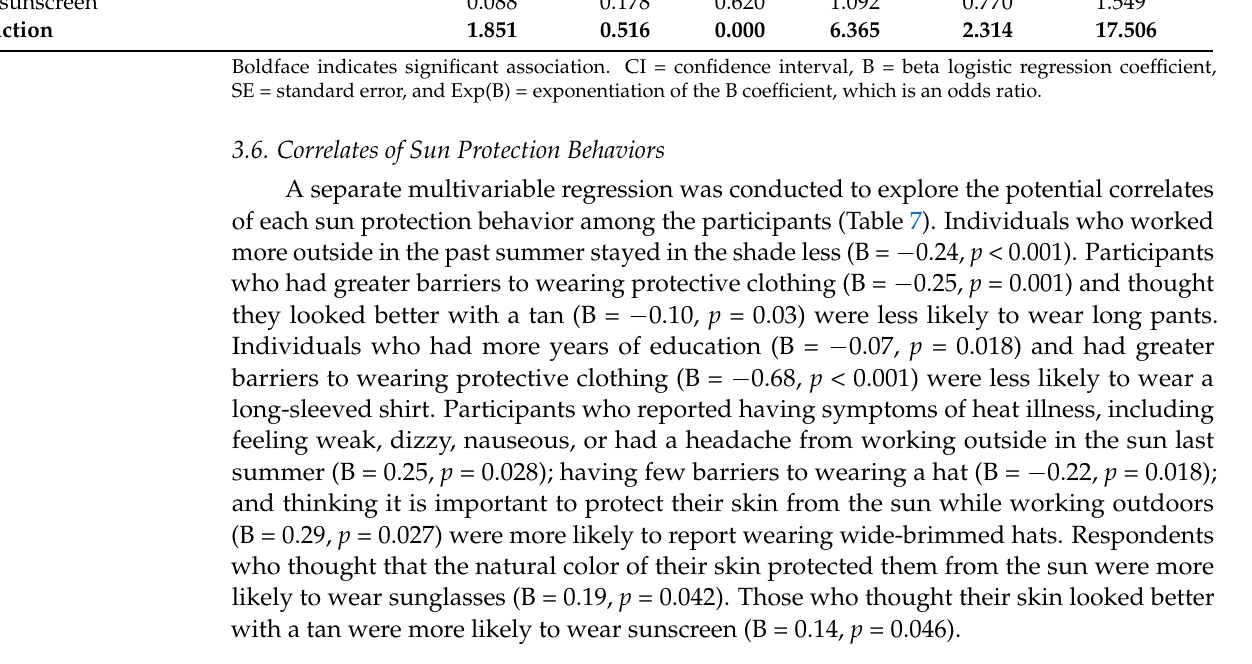
Table 7. Significant correlates of sun protection behaviors among Hispanic outdoor day